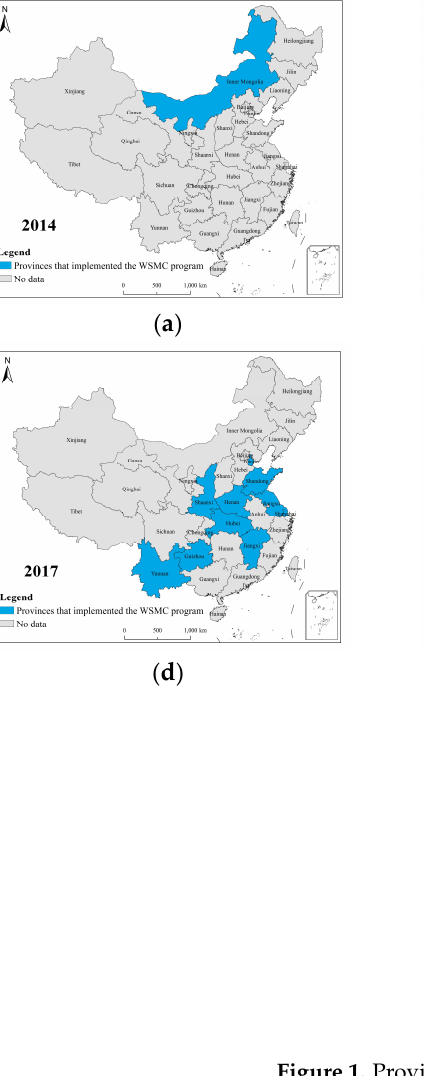
( b ) Figure 3. The implementation of WSMC projects between 2016 and 2020 by province, where ( a ) is the number of WSMC projects; ( b ) is the investment amount of WSMC projects. Figure 3 shows that among the 181 implemented WSMC projects, Yunnan Province has implemented the most WSMC projects, with a total quantity of 33. Jiangsu Province has implemented the second most WSMC projects, with a total of 26. Shaanxi Province has implemented a total of 21 WSMC projects, ranking third. Yunnan Province is the prov- ince with the highest investment amount over the years (approximately CNY 884 million), accounting for 42.70% of the total investment in China. Most WSMC projects are PPP pro- jects for efficient agricultural irrigation. Jiangsu Province ranks second in terms of invest- ment, with a total investment of CNY 422 million, and the projects cover the five fields, with the majority of the projects in public institutions (accounting for 84.62%). The total investment amount of WSMC projects in Yunnan and Jiangsu Provinces accounted for 63.1% of total investment in China, and the total investment amount of WSMC projects in each of Ningxia, Heilongjiang, Beijing, Jilin, Anhui, and Hunan was below CNY 4 million.